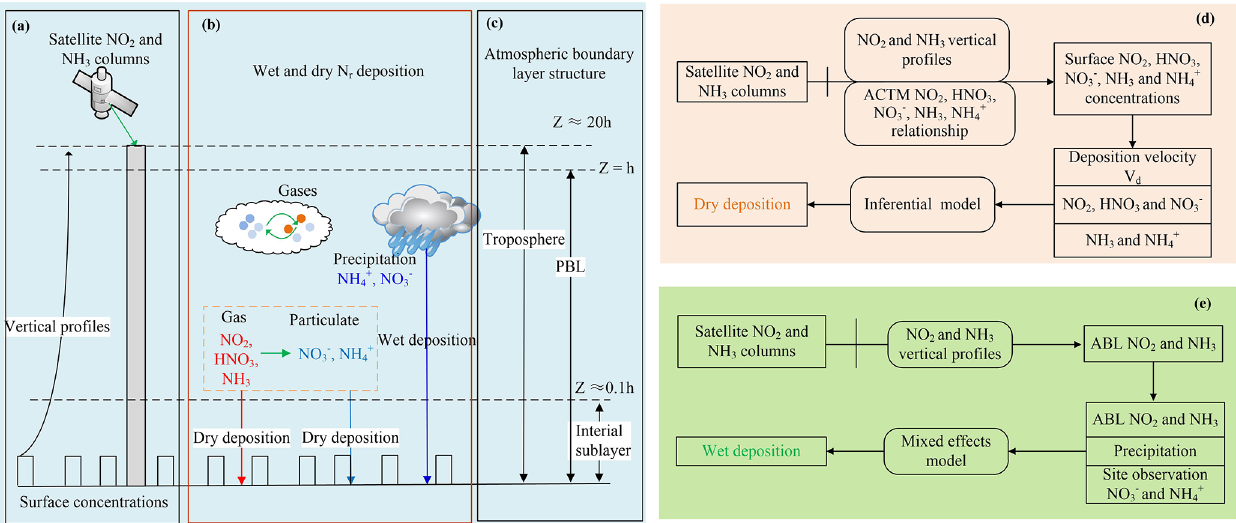
Figure 1. Schematic diagram of dry and wet N r deposition. (a) indicates the satellite-observed NO 2 and NH 3 column and the vertical profiles by an ACTM; (b) shows dry and wet N r deposition including the major N r species (gaseous NO 2 , HNO 3 , NH 3 , particulate NO − as well as wet NO − and NH + in precipitation); (c) illustrates atmospheric vertical structures including the troposphere (satellite observation), 3 4 atmospheric boundary layer (ABL), and interfacial sub-layer; (d) and (e) represent procedures of calculating the dry and wet N r